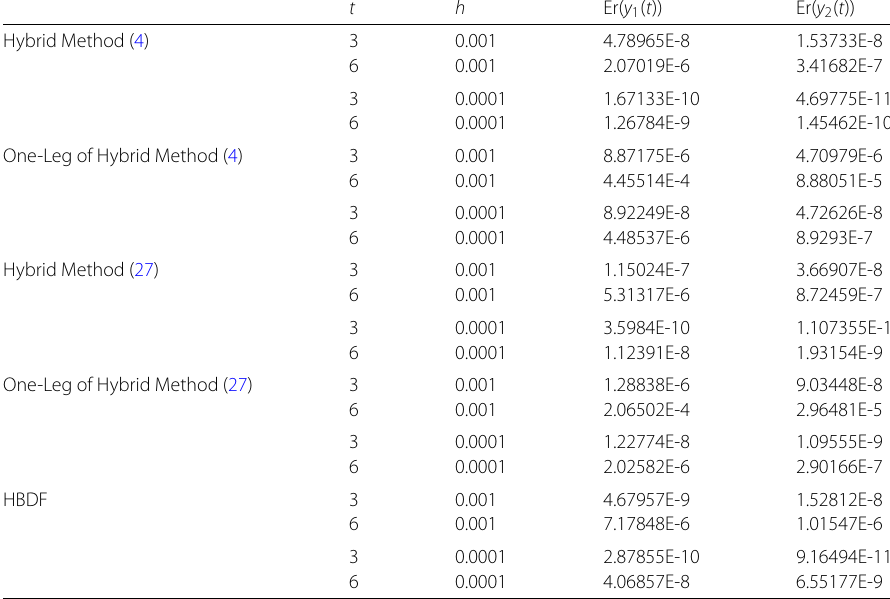
Table 6 The error of the first